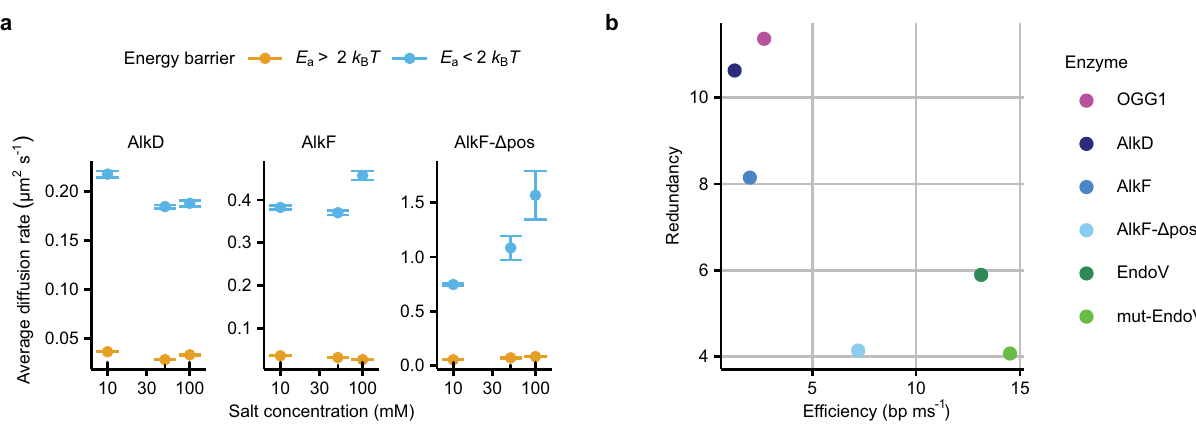
Fig. 3 Hopping, redundancy, and ef fi ciency of DNA scanning. a The average diffusion rate for modes of scanning with high (yellow) and low (blue) activation barriers as a function of salt concentration. The error bars show the standard error of the mean (SEM). b Comparison of redundancy and ef fi ciency of DNA scanning for six proteins. x axis: ef fi ciency; the average rate at which bases are covered in each binding and scanning event (bp ms − 1 ). y axis: redundancy; the average number of times each base pair is visited per binding and